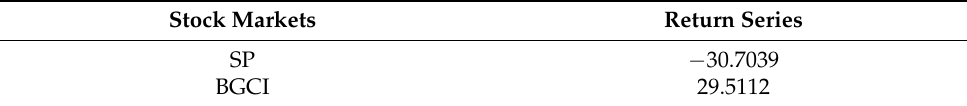
Table 2. Unit root test.